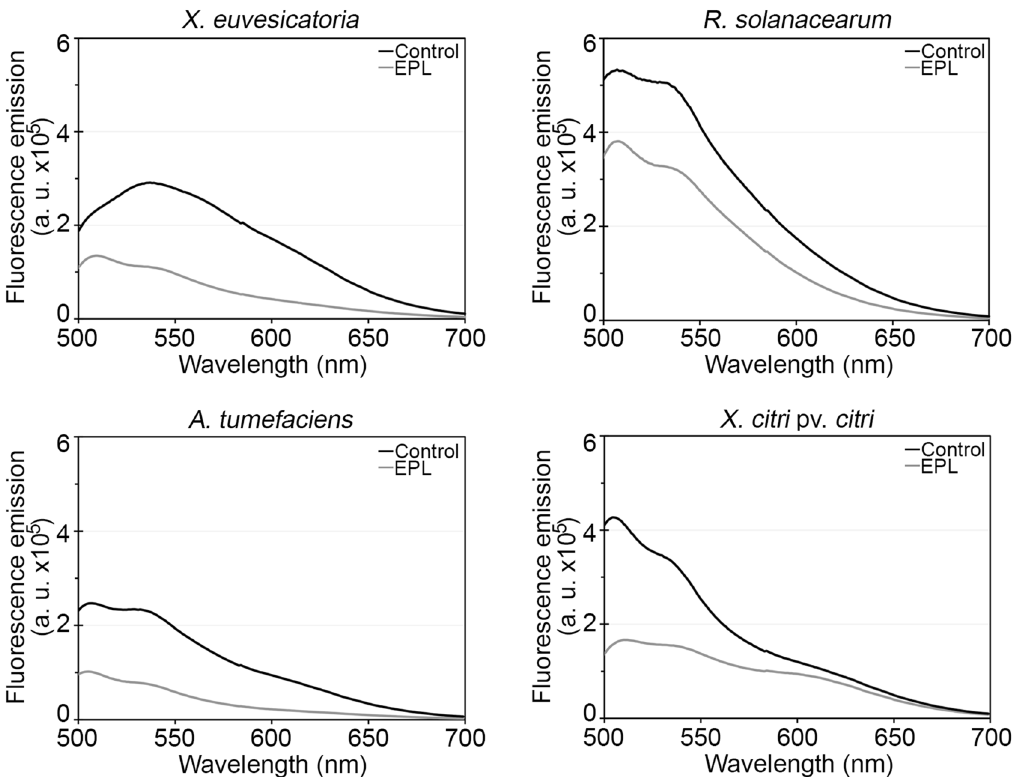
Figure 3. Cell viability measured by fluorescence emitted by bacterial cells treated with EPL at MIC for one hour. SYTO 9 was added to the bacterial suspensions and incubated for 15 min in the dark. Samples were excited at 470 nm and emission spectrum (490–700 nm) was recorded. A lower emitted fluorescence near 530 nm indicates a lower number of viable cells. Controls included water-only treatment (non EPL-treated) and EPL with fluorophore (without bacterial cells). Values shown are the average of three biological replicates.